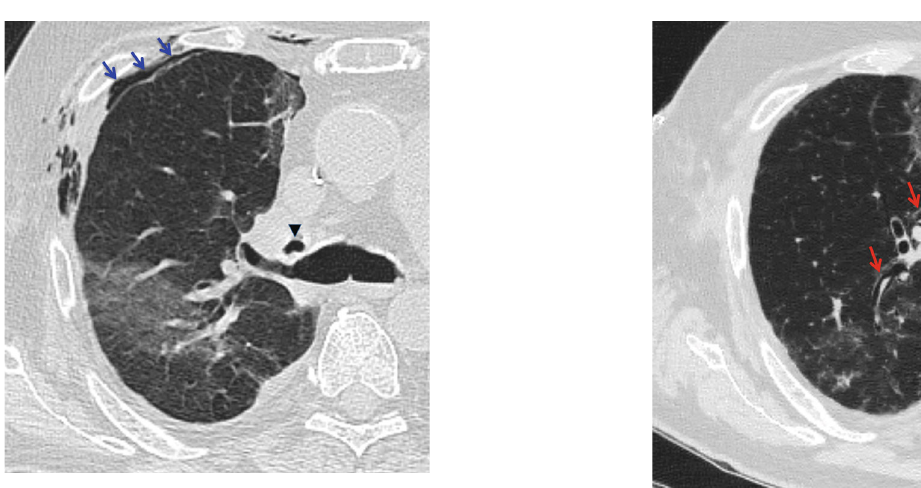
Figure 2: Axial chest CT showed a sentinel pocket of gas adjacent to the right bronchial anastomotic site (black caret); an anterior pneumothorax (blue arrows) is also seen.